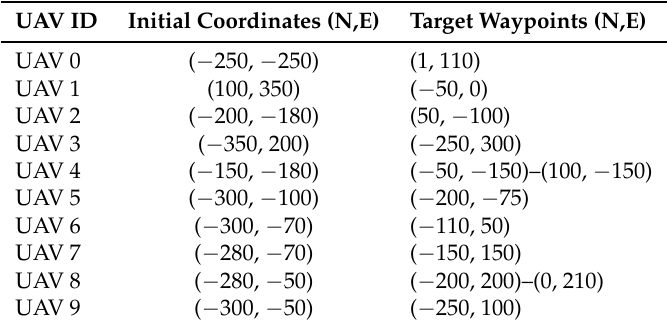
Table 5. Simulation of collision avoidance of MUAVS: Case